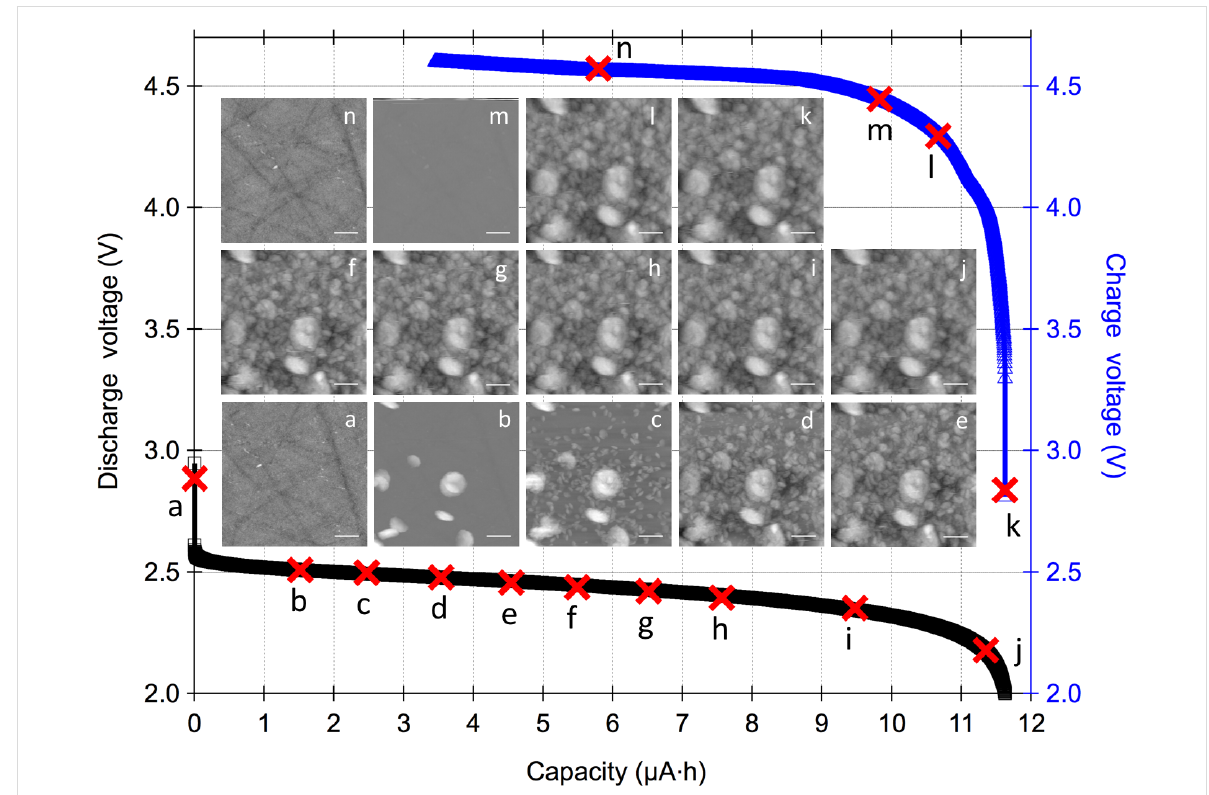
Figure 4: Electrochemical discharge (black, left y -axis) and recharge (blue, right y -axis) curves with topography images from simultaneous AFM scans. The X marks on the curves denote the discharge or recharge capacity at the end of the AFM scan. The AFM images (3 × 3 µm) were collected in 1 M LiNO 3 in TEGDME with ≈ 2500 ppm of water in the electrolyte from one of the nine spiral spots as shown in Figure 1. The discharge current was 5 µA. Nanostructured electrochemical deposits abruptly appear ( ≈ 4% capacity) on the cathode surface during the initial stages of discharge. Figure 4b is at 12.7% discharge capacity. In Figure 4c–e smaller nanostructures appear to nucleate and grow on the cathode surface. In Figure 4f–j the size of the deposits continues to increase along with fresh nucleation and growth on all areas. During recharge the nanostructures abruptly disap- pear between 14% and 18% of the recharge capacity with the last of the deposits captured in three traces in Figure 4m. The Z scale for Figure 4a and 4n is 50 nm and Figure 4b–l is 500 nm. 184 total images are collectively presented in Movie 2 (Supporting Information File 3) for time domain visuali- zations of all the nine areas scanned on the